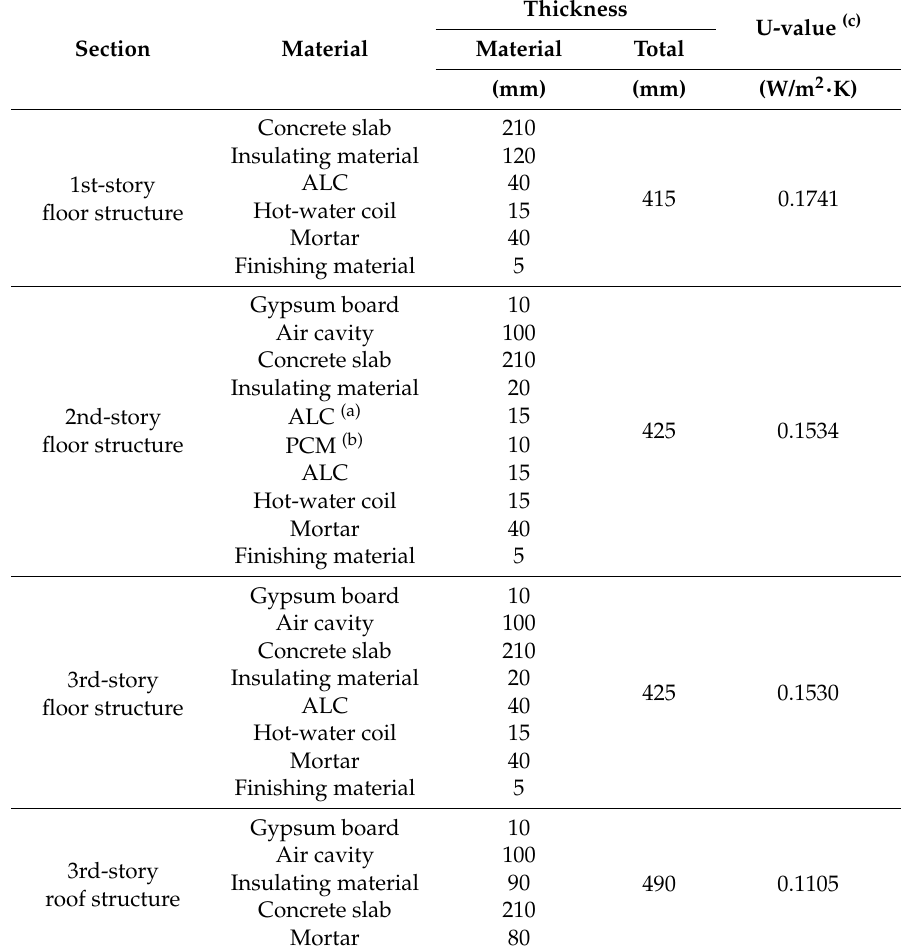
Figure 5. Floor plan of the apartment building (left) and modeling by simulation (right). Table 4. Structures and characteristics of building envelopes [20].